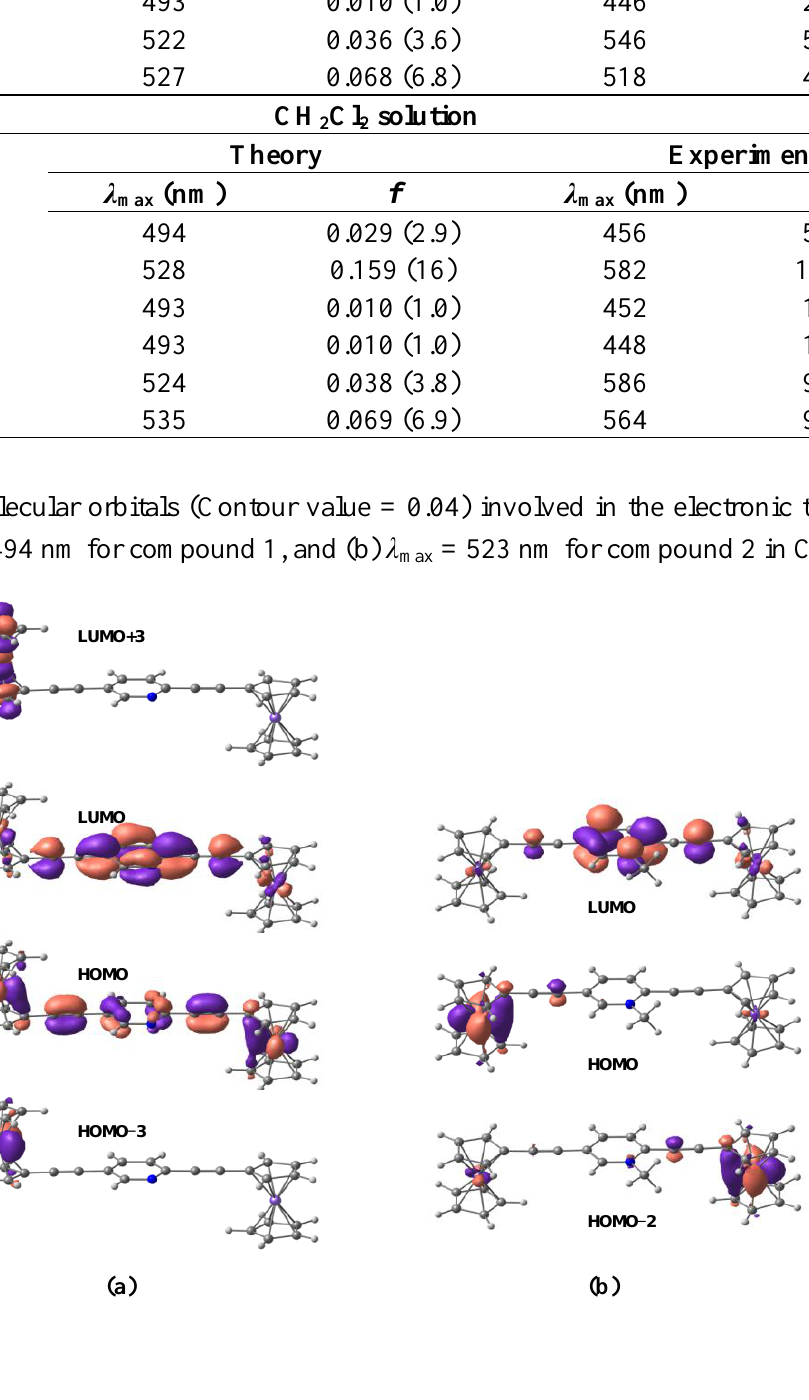
Table 2. Calculated lowest-energy absorption maxima for compounds 1a, 2a and 5–8. The theoretical oscillator strength ( f ) and the experimental extinction coefficient ( ε ) are also listed. The relative values of f and ε are also listed in the parenthesis.